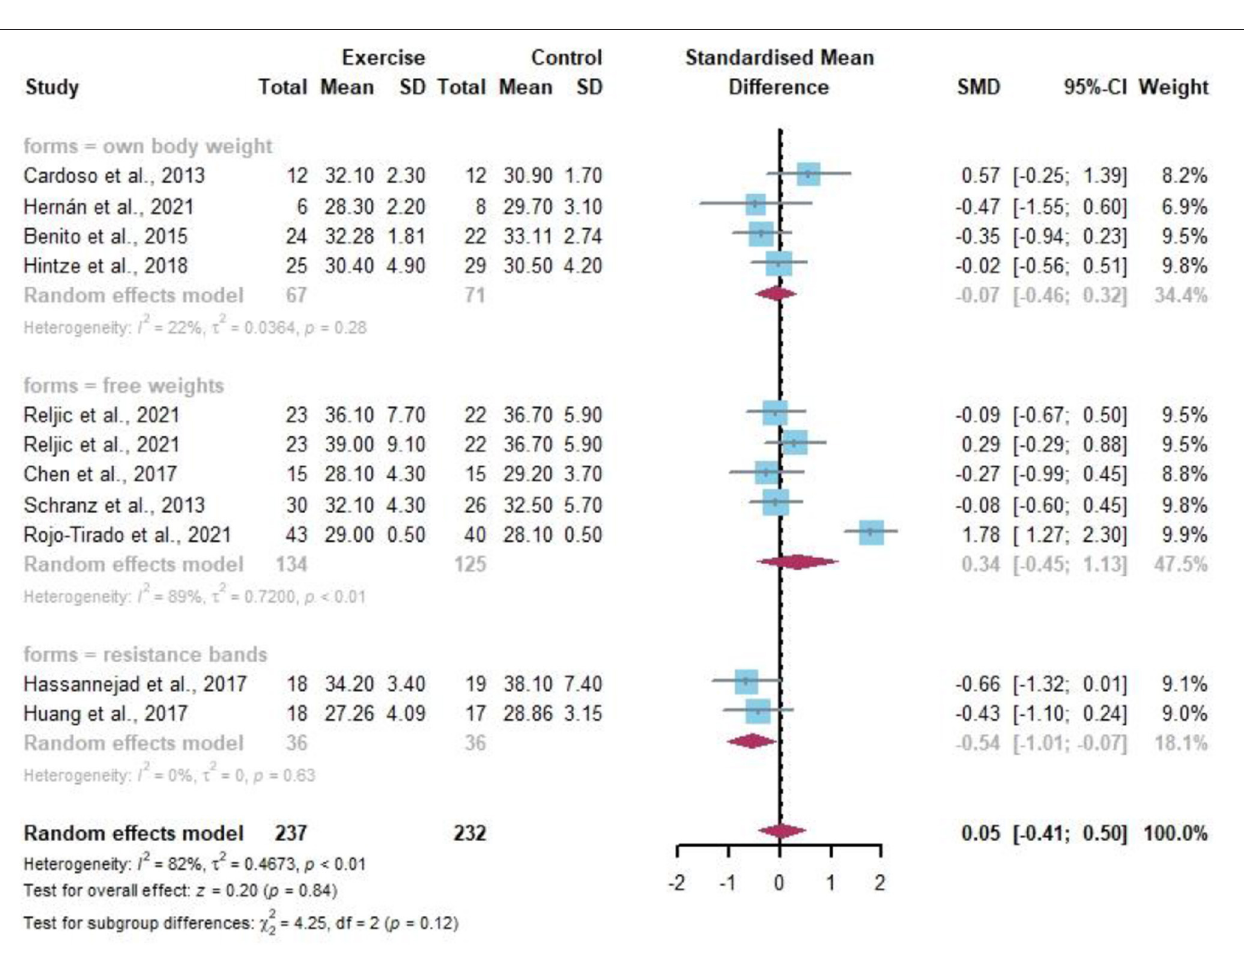
FIGURE 6 | Meta-analysis of effects of different resistance exercise forms on body mass index (BMI) of overweight and/or obese